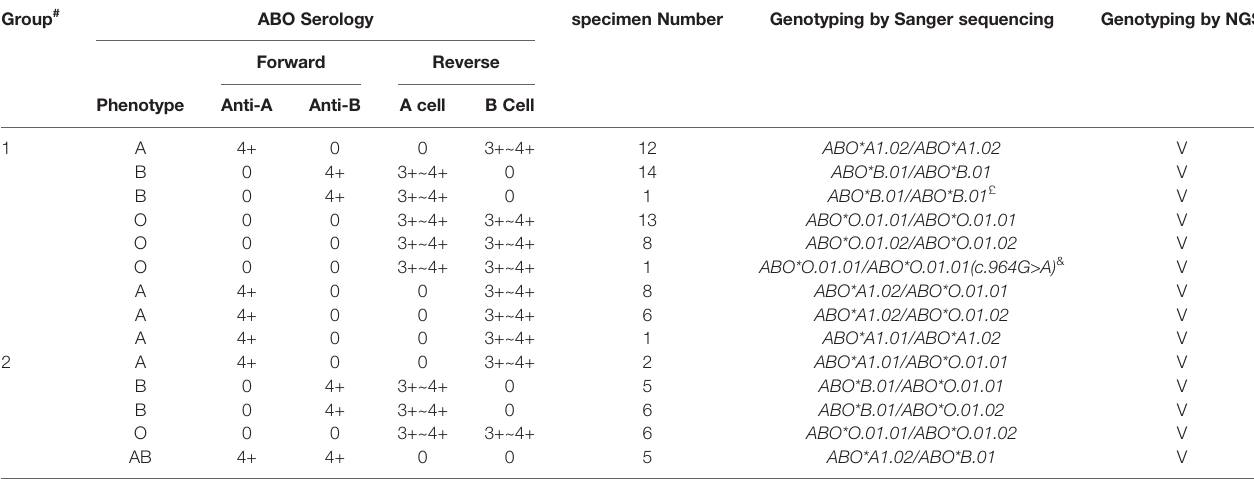
TABLE 2 | The results for 88 individuals with four common ABO phenotypes.